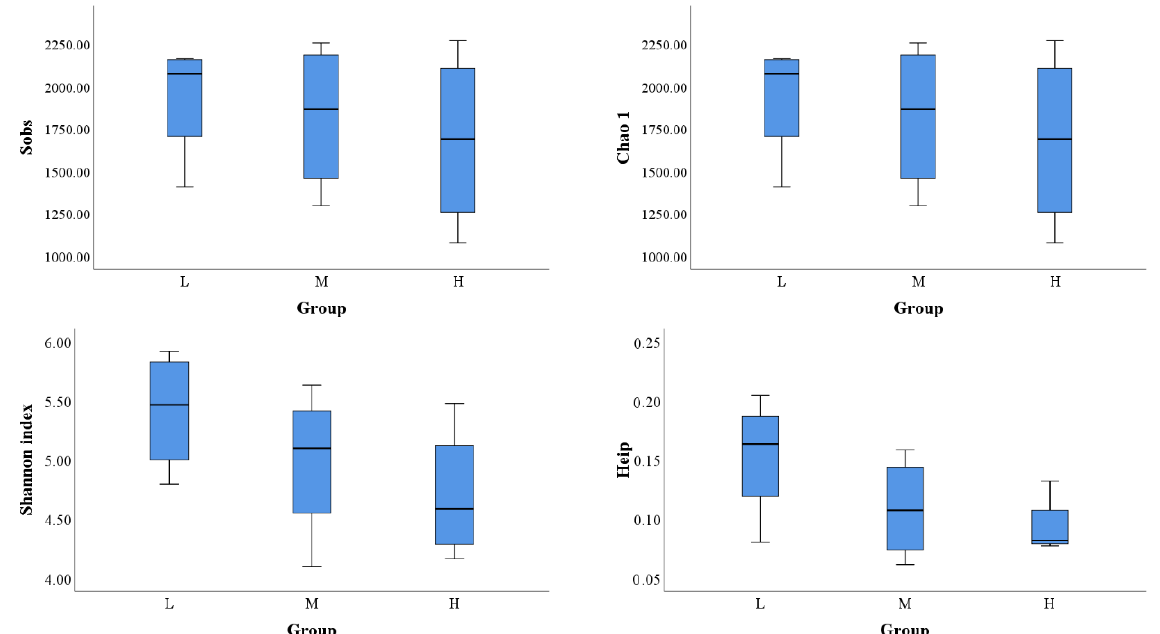
Figure 2. Alpha diversity indices of the microbial communities of the sampled lakes on the Tibetan Plateau, China (L: Low saline lakes M: Moderately saline lakes H: High saline lakes).